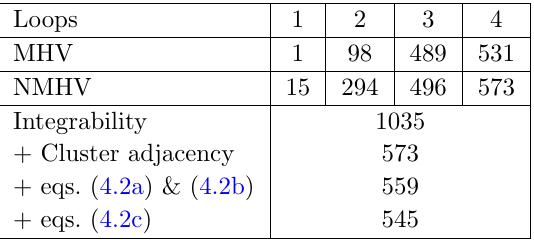
Table 4 . Number of independent integrable weight-2 words appearing in the seven-particle ampli- tudes at given loop level. Note that the sets are inclusive with increasing loop number, that is the words appearing at lower loop are part of those at higher loop. In the last four rows we give the number of independent weight-2 words that are theoretically possible considering the seven-particle alphabet and imposing only integrability or also cluster adjacency or also the restrictions to